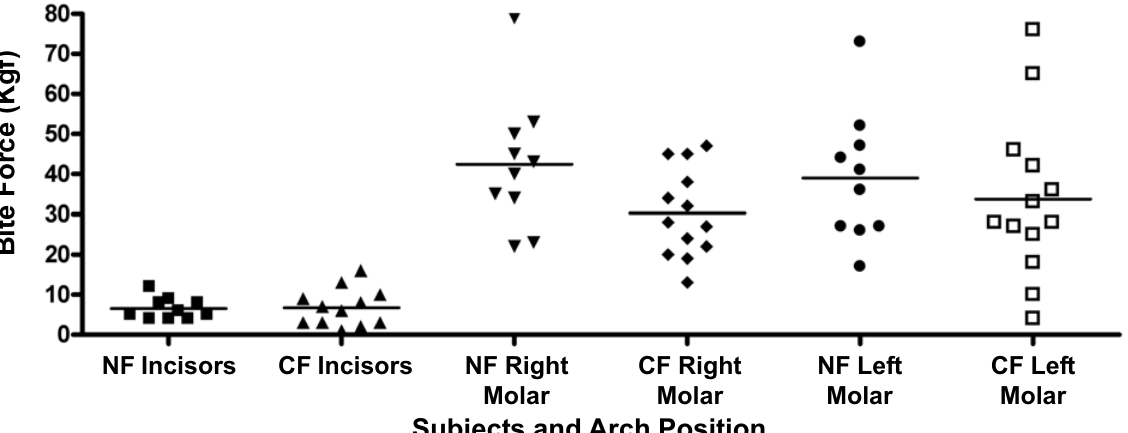
FIGURE 2- Maximum isometric bite force in the female group: Noncleft Female subjects (NF) and repaired cleft lip and palate female patients (CF) (kgf). Data representative of values performed by each subject. No statistically significant difference was observed between NF and CF